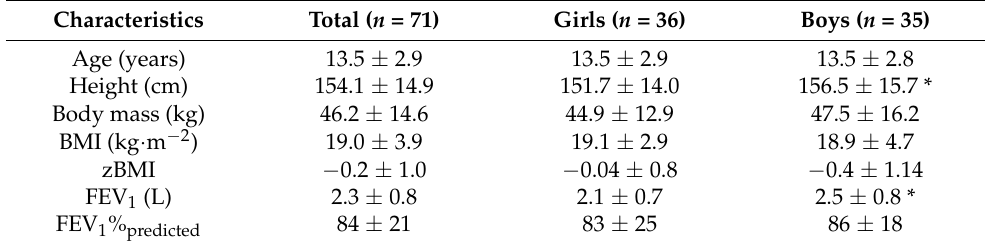
Table 1. Participant Characteristics by Sex.